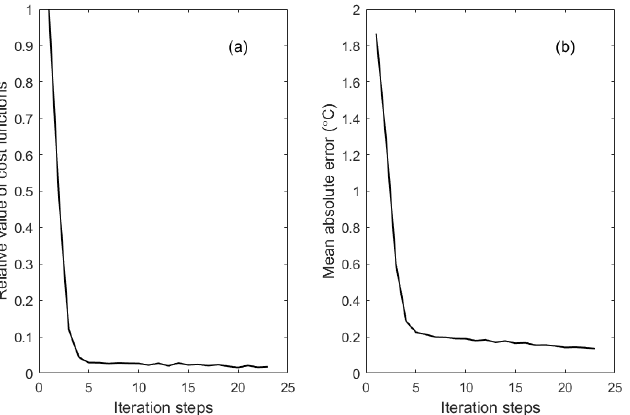
Figure 7. Cost function ( a ) and MAE ( b ) change related to the iteration steps in ideal experiment II.